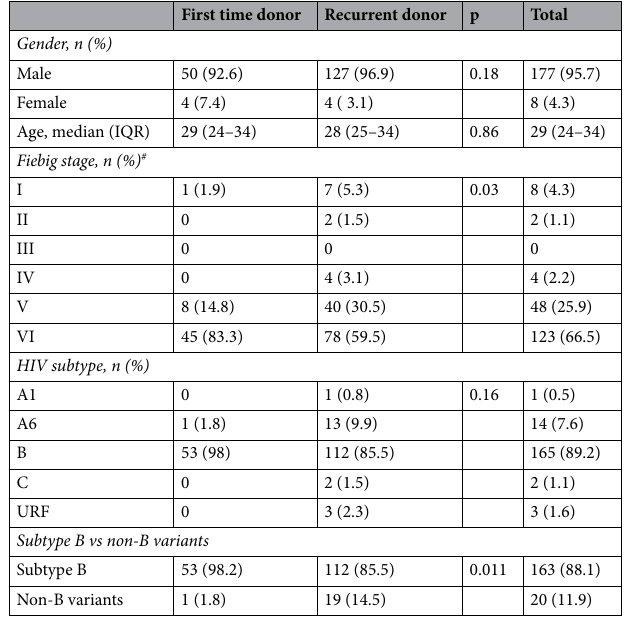
Table 1. Baseline cohort characteristics by first time/recurrent donors. # There were no individuals with Fiebig stage